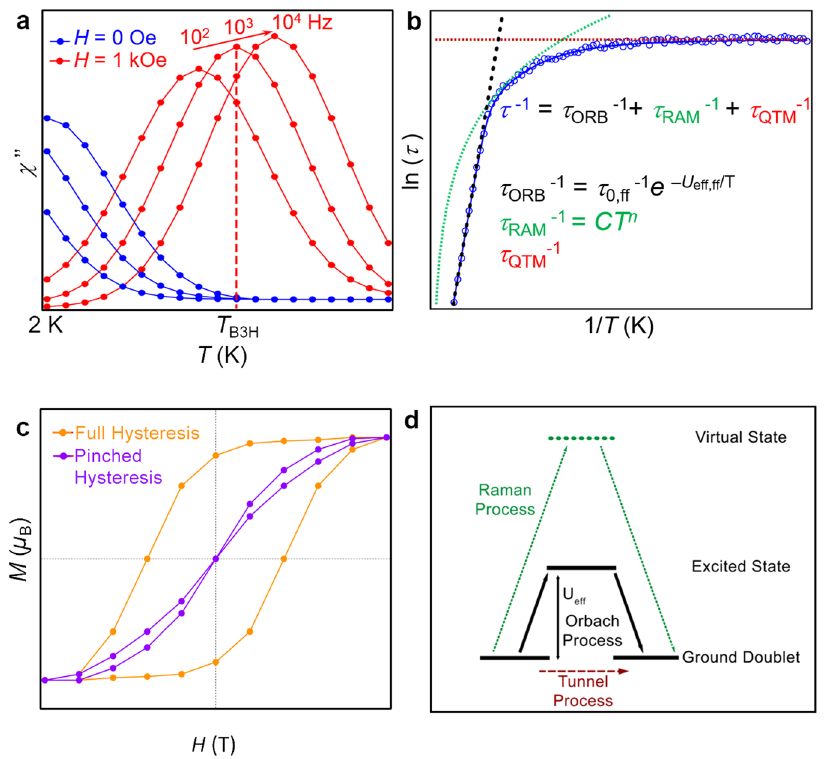
Fig. 1 | Main magnetic concepts employed in this study. Slow relaxation of the magnetisation in SIMs can manifest in different ways. a Spin blocking is often characterised by a temperature- and frequency-dependent out-of-phase ac sus- ceptibility χ ” , being T B3H the temperature for the maximum χ ” at 10 3 Hz in the presence of a magnetic fi eld. b These relaxation dynamics have most often been modelled as an Orbach process (black dots), using the Arrhenius equation. Raman